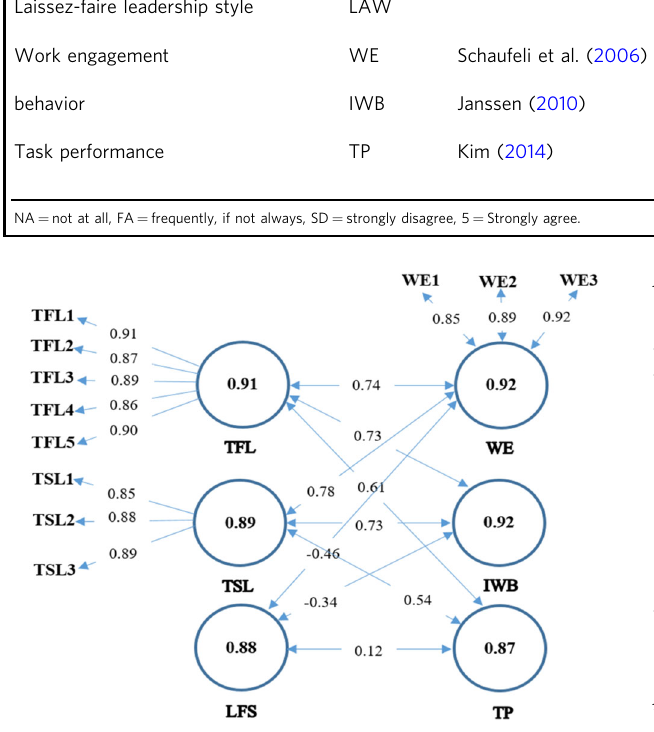
Fig. 2 Measurement model. Structural equation results in the relationship between leadership styles and leadership performance and employee work